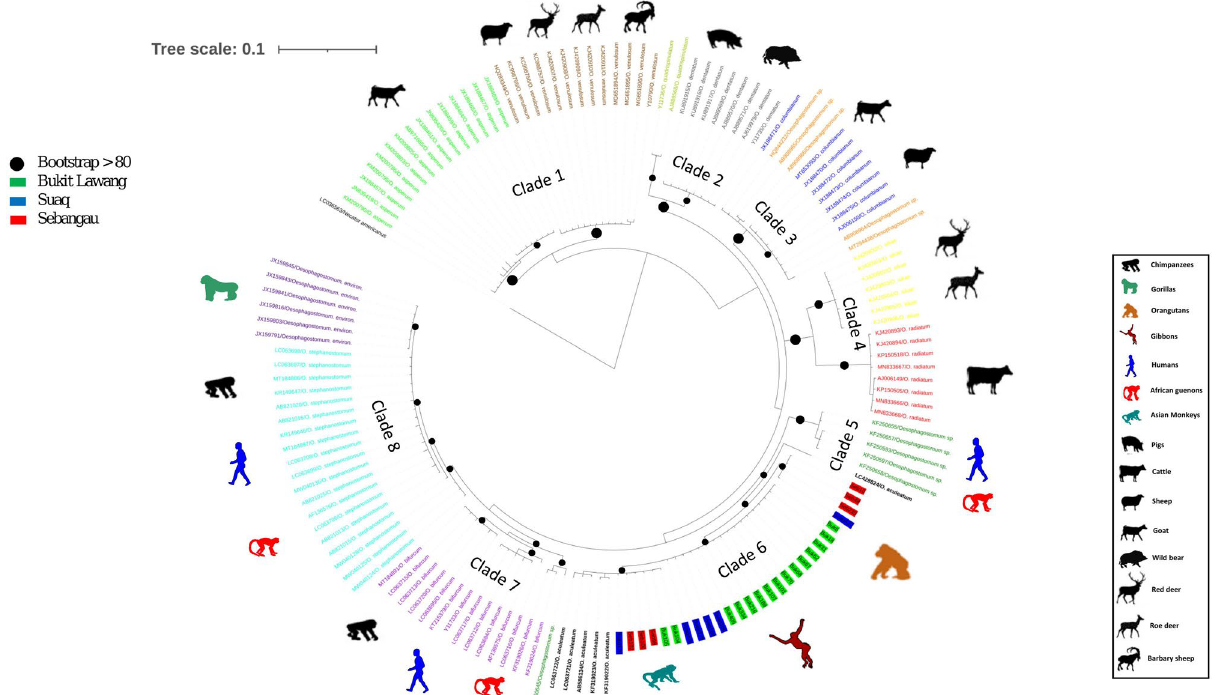
Figure 3. Phylogenetic relationship among Oesophagostomum isolates based on ITS2 rDNA (258 bp) sequences. The best-fitting model under the Akaike information criterion was HKY86 + G6 for nucleotides as identified by JModelTest v.0.1.1. Scale bar indicates nucleotide substitution per site. High (> 80) bootstrap support are indicated next to the respective node by dots in black, respectively. O. aculeatum sequences are identified in this study are indicated with text-highlighted colour, sequences taken from NCBI are presented with font colour.